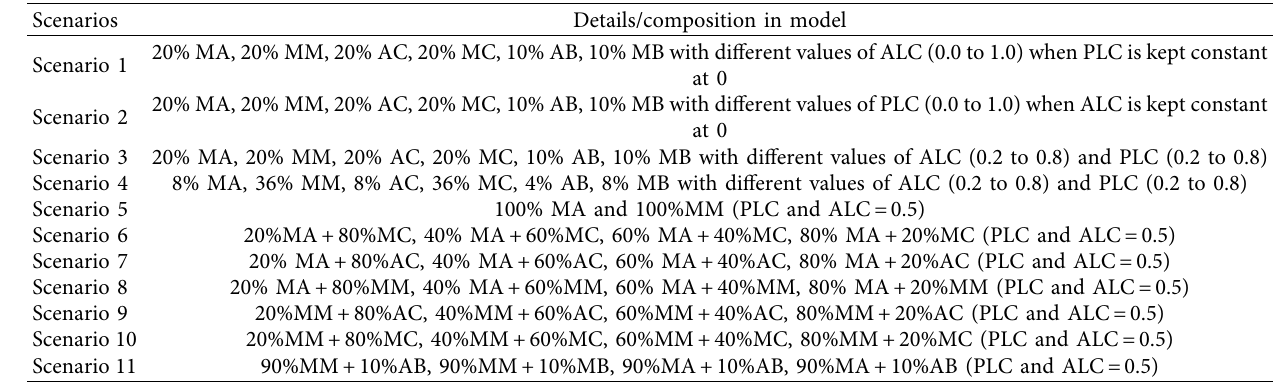
Figure 2: Flow chart of lane change. Table 3: Details of different scenarios.